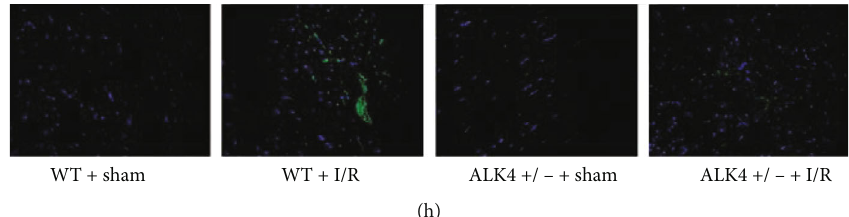
Figure 2: Detection of cell aging, cell apoptosis, and related molecules in di ff erent groups: WT+sham group, WT+I/R group, ALK4 +/- +sham group, and ALK4 +/- +I/R group. (a) HE staining of cell aging. (b and c) Detection of protein expressions of TGF β , AKT1, STAT3, and NF- κ B (Western blotting). (d – g) Detection of protein expressions of phosphorylated Smad2/3 (p-Smad2/3), Smad4, Smad6, and Smad7 (Western blotting). (h) Green: apoptotic cells (TUNEL staining); blue: nuclei (DAPI counterstaining, × 400). ∗ P < 0 : 05 and ∗∗ P < 0 : 01 , WT+I/R group vs. WT+sham group. # P < 0 : 05 and ## P < 0 : 01 , ALK4 +/- +I/R group vs. WT+I/R